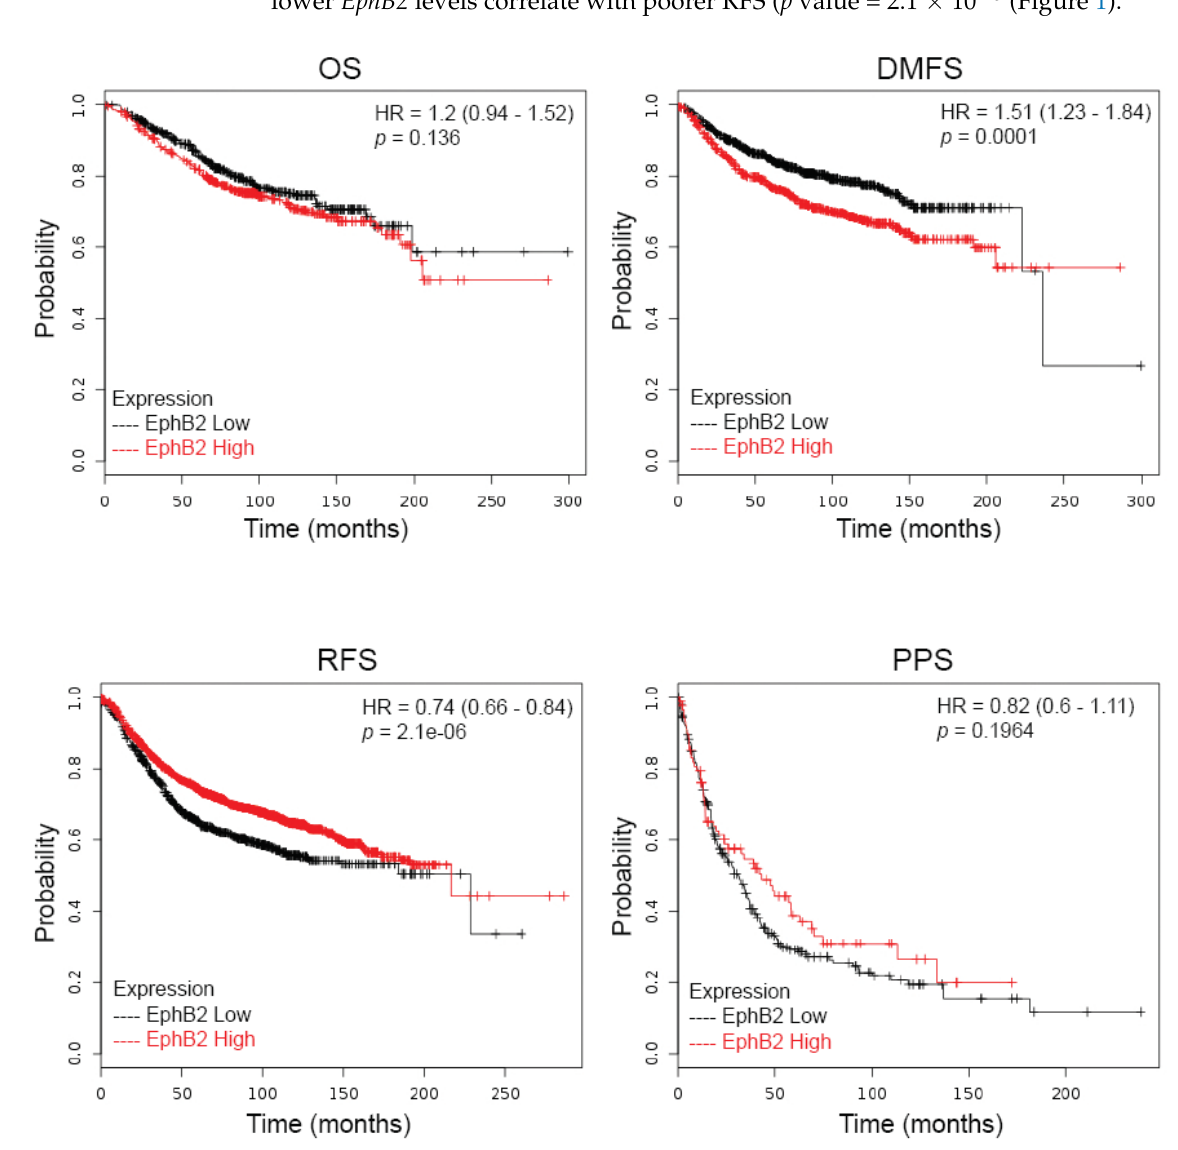
Figure 1. Prognostic value of EphB2 expression in breast cancer. Kaplan–Meier curves were generated using four types of breast cancer patient survival data from www.kmplot.com: overall survival (OS), relapse-free survival (RFS), distant metastasis-free survival (DMFS), and post-progression survival (PPS). Survival of two groups of patients, with low versus high EphB2 mRNA expression levels, was compared, and both hazard ratios (HR) with 95% confidence intervals and log-rank p values were calculated.